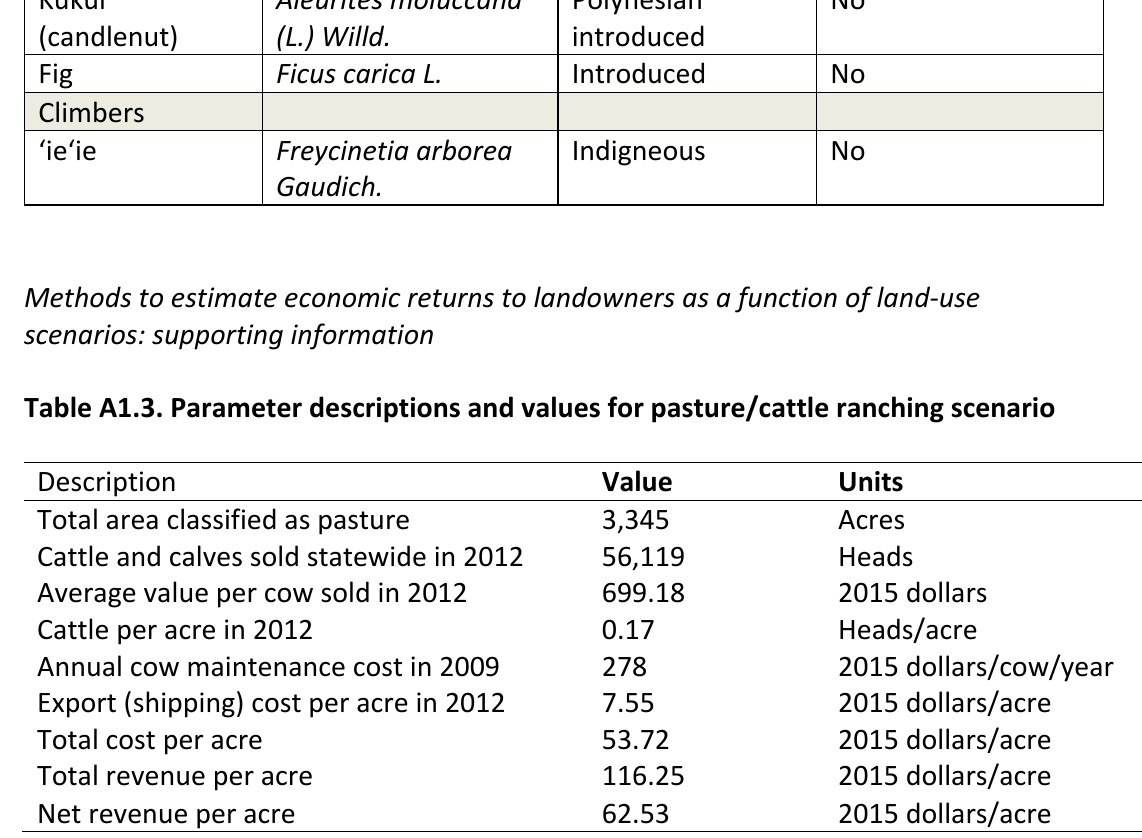
Table A1.4. Annual revenue and costs for pasture/cattle ranching scenario